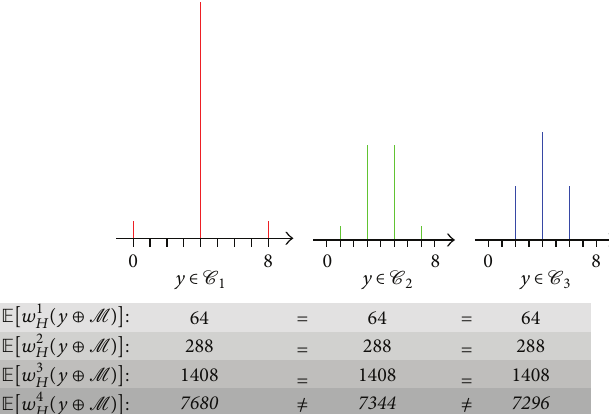
Figure 5: Distribution ℎ ∈ ⟦0, 8⟧ of the Hamming weights of the cosets 𝑦 ⊕ M of the RSM code M .